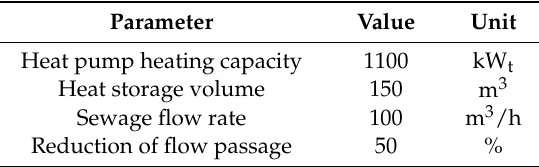
Table 1. Initial configuration of the system.